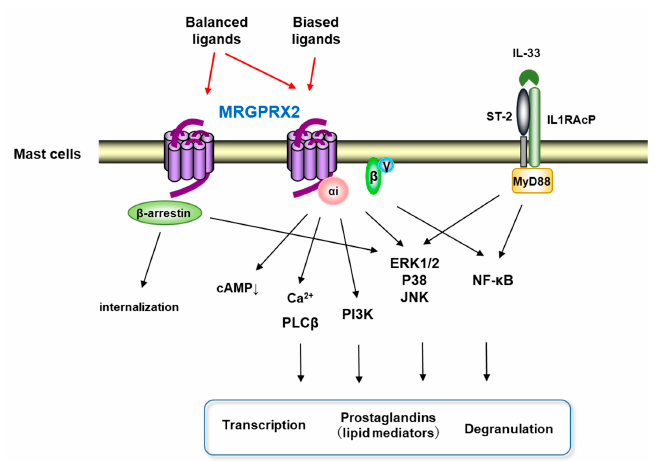
Figure 1. Scheme of the signal pathway after MGPRX2 activation. MRGPRX2 ligands activate Gi protein, which induces a cAMP decrease, Ca 2+ mobilization, and also activates MAPKs, PI3K, and NF- κ B pathways, which lead to degranulation, induction of transcription, and production of prostaglandins. Balanced MRGPRX2 ligands not only activate Gi protein but also recruit β -arrestin to induce internalization, while biased MRGPRX2 ligands cannot recruit β -arrestin. Additionally, IL-33 enhances MRGPRX2 signaling by activating MAPKs and NF- κ B.